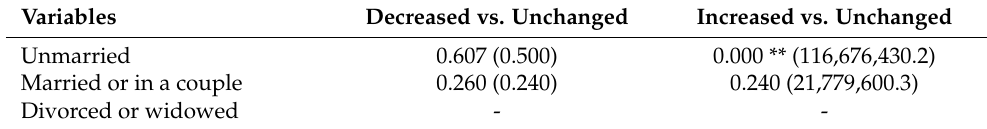
Table 4. Change in importance evaluation of social health benefits, explained by marriage.